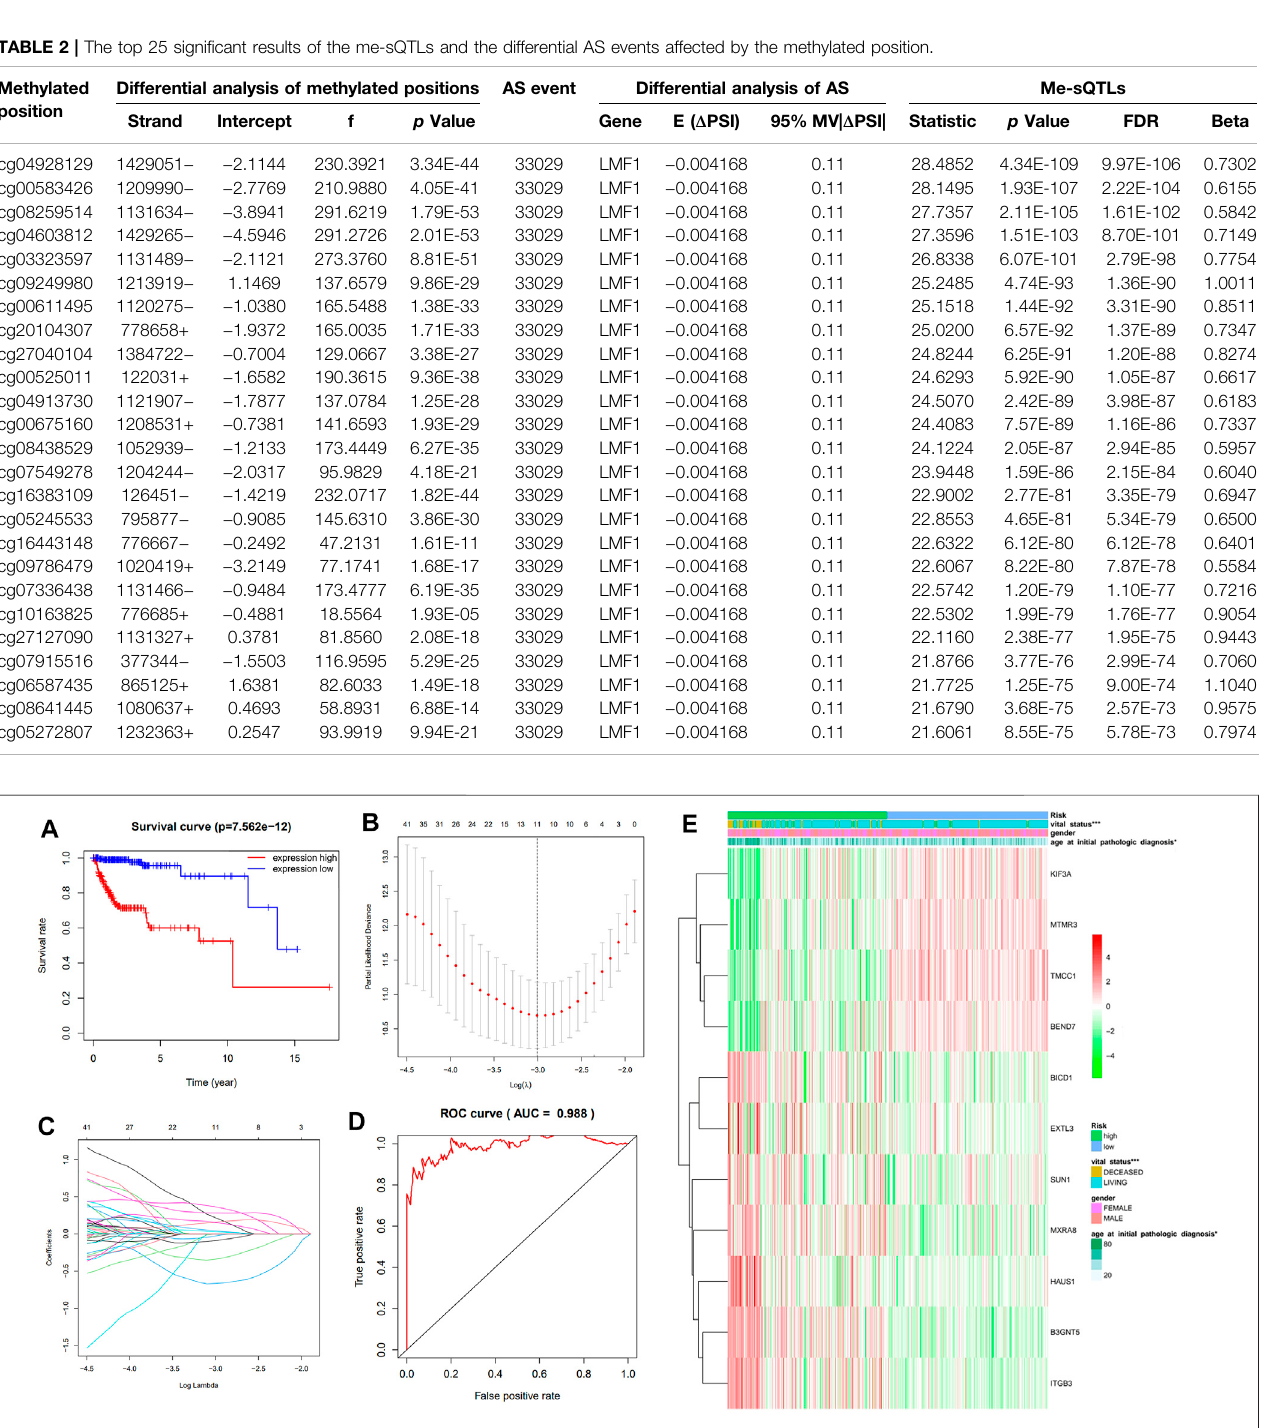
FIGURE 4 | The in fl uence of the glioma-related genes whose AS signi fi cantly affected by DNA methylation level on the disease prognosis. (A) The Kaplan-Meier overall survival curves of the low (red) and high (blue) expression groups. (B) and (C) show the results of LASSO regression. There are 11 independent genes with their coef fi cient when the partial likelihood deviance reaches its minimum value. (D) The ROC curve reveals the reliability of the risk score by comparing the true and false positive rate. (E) The heatmap shows the association between the risk scores ofthe prognosis-related me-sQTL genesand the clinical features of glioma patients.